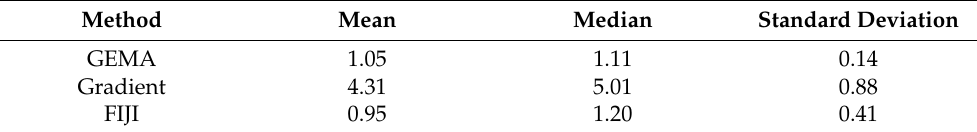
Table 3. A summary of statistical measures by each method according to the processing time.